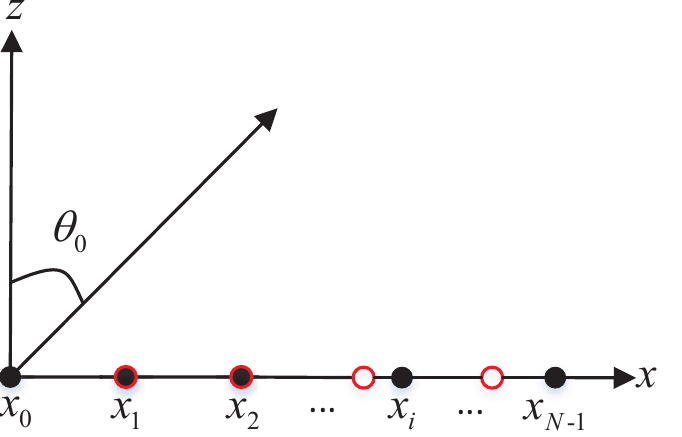
Figure 1. Schematic of the array element